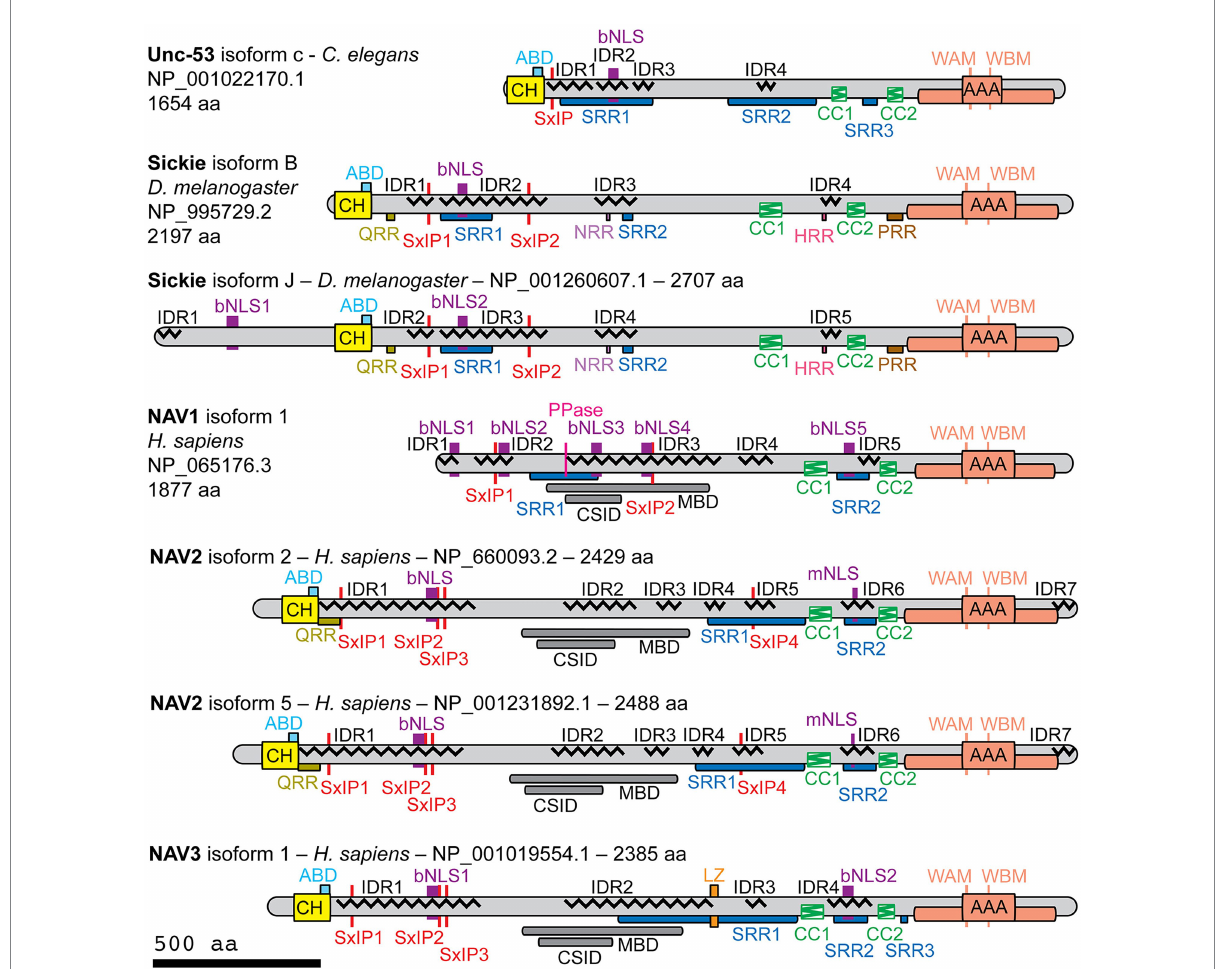
FIGURE 1 Structural features of NAV family proteins as determined by protein sequence analysis. Indicated isoforms of Unc-53 ( Caenorhabditis elegans ), Sickie ( Drosophila melanogaster ), and human NAV1, NAV2, and NAV3 were analyzed using protein sequence algorithms. The catalytic core of each AAA+ domain is indicated by the central box, with additional conserved domain components indicated by the surrounding box. Abbreviations: ABD, actin-binding domain (putative); bNLS, bipartite nuclear localization sequence; CC, coiled-coil; CH, calponin homology; CSID, cytoskeletal- interacting domain (putative); HRR, histidine-rich region; IDR, intrinsically disordered region; LZ, leucine zipper (putative); MBD, microtubule- binding domain (putative); mNLS, monopartite nuclear localization sequence; PRR, proline-rich region; PPase, inorganic